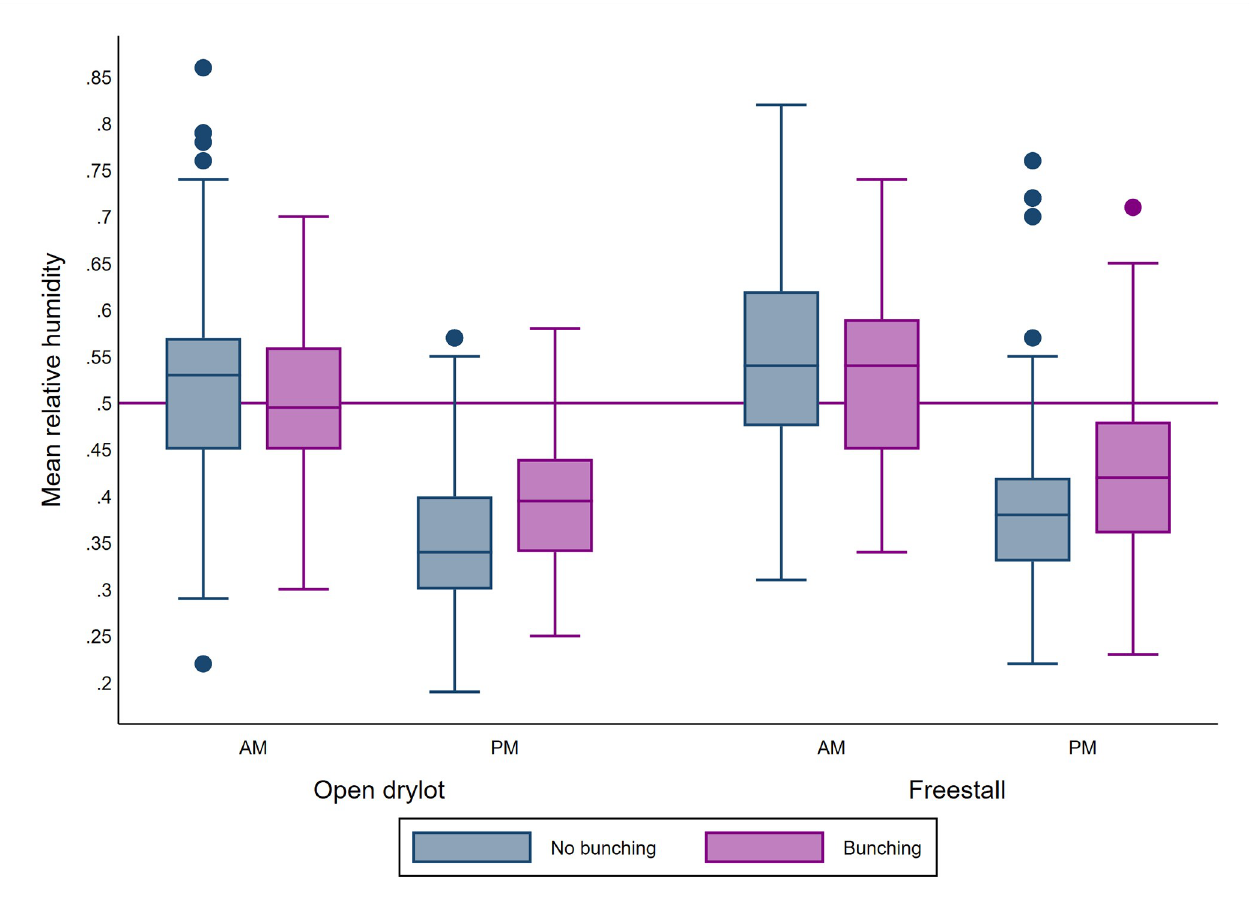
Fig 5. Boxplot of mean ambient temperature(˚C) during AM and PM counts and bunching according to the pen design. The upper and lower horizontal lines of the box represent the 25 th and 75 th percentiles respectively, the horizontal midline represents the median, the upper and lower horizontal whiskers lines are the upper and lower limits and the dots are the